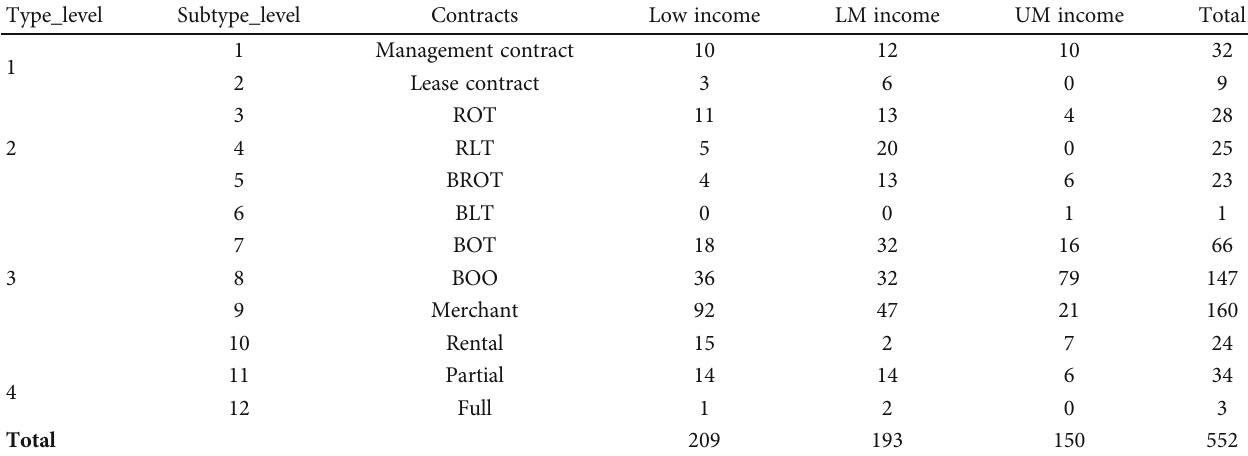
Table 4: Summary of the type/subtype of PPI of the sampled Green PPP projects.